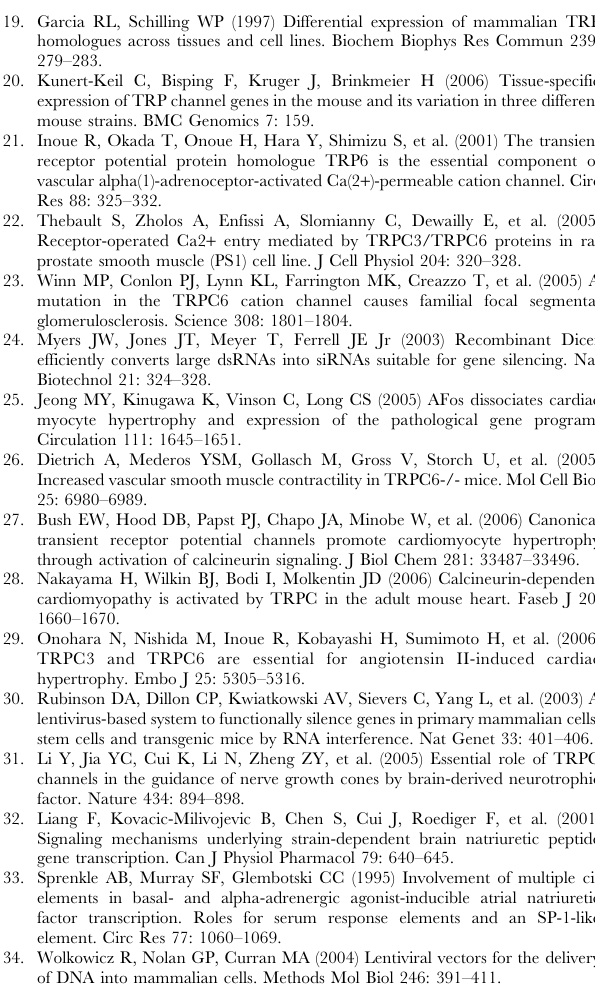
Table S2 PCR primers used in real-time